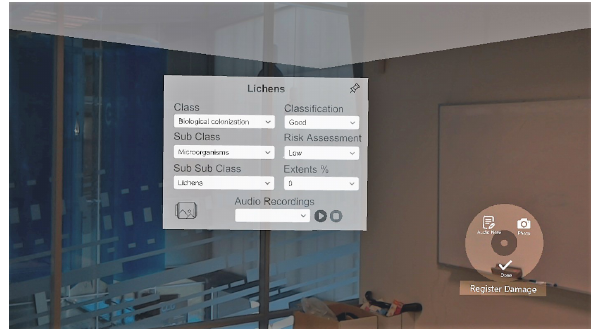
Figure 5. The main damage form.